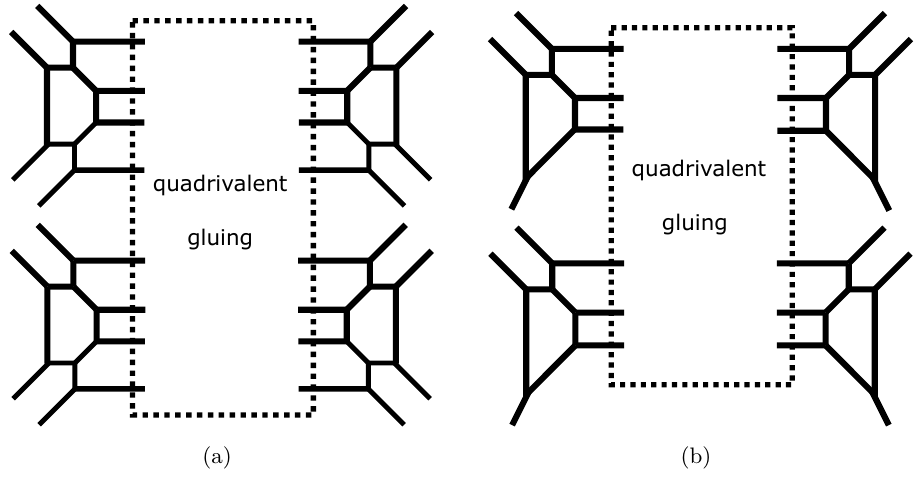
Figure 2. (a): The web diagram for the theory in (2.27), which gives a circle compactification of ( D 4 , D 4 ) 2 . (b): The web diagram for the theory in (2.29), which gives a circle compactification of ( D 4 , D 4 ) 1